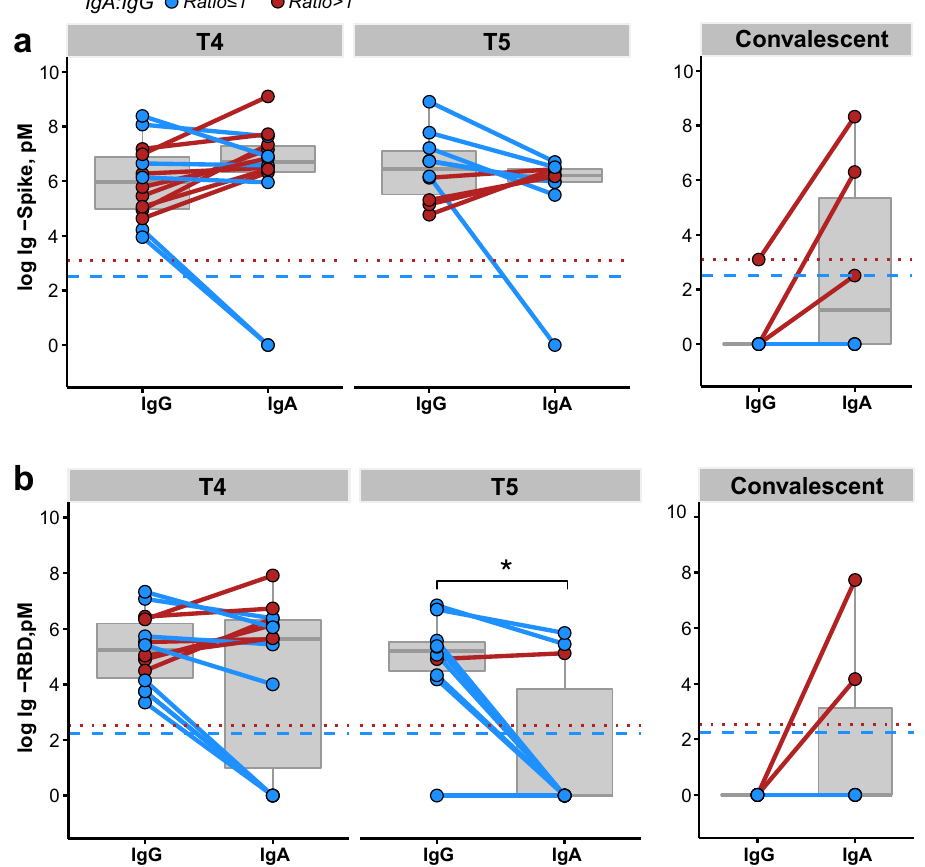
Fig. 3 Vaccinated women have both SARS-CoV-2-speci fi c IgA and IgG in human milk unlike convalescent women. a Concentration [pM a ] of spike IgA and IgG in vaccinated women at T4 ( n = 14) and T5 ( n = 10) or in convalescent women ( n = 6). b Concentration [pM a ] of RBD IgA and IgG in vaccinated women at T4 ( n = 14) and T5 ( n = 10) or in convalescent women ( n = 6). Each solid line represents one individual, and is colored to whether the IgA to IgA ratio was decreased (blue), or increased (red). Ratios were calculated by dividing the concentration of IgA over IgG antibodies. The red dotted line denotes the IgA detection limit, while the blue dotted line denotes the IgG detection limit in all assays. p values were calculated with Wilcoxon signed rank exact test, * p < 0.05, ** p < 0.01, *** p < 0.001, n.s. non-signi fi cant. Box and whiskers plots (in gray) show median (center line), interquartile range (box), and 10th and 90th percentiles (whiskers). RBD receptor-binding domain, IgA immunoglobulin A, IgG immunoglobulin G, pM a picomolar. a SI conversion factors: to convert concentration from pM to M, multiply values by 10 12